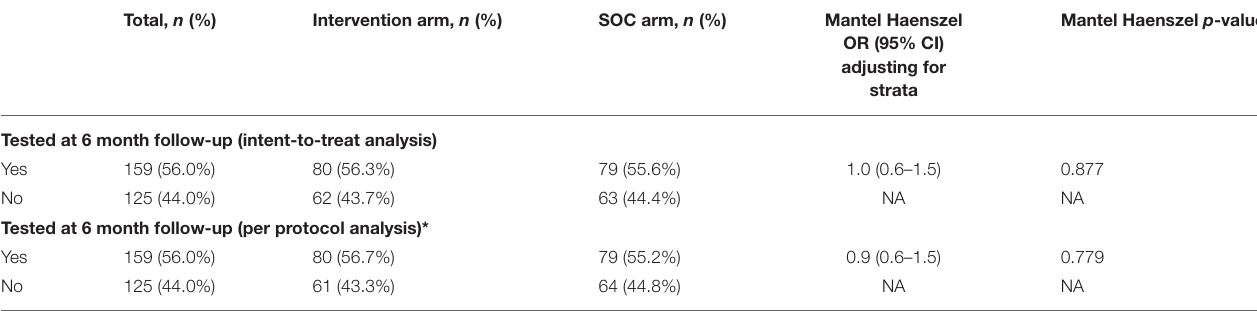
Mantel Haenszel p -value OR (95% CI) adjusting for strata